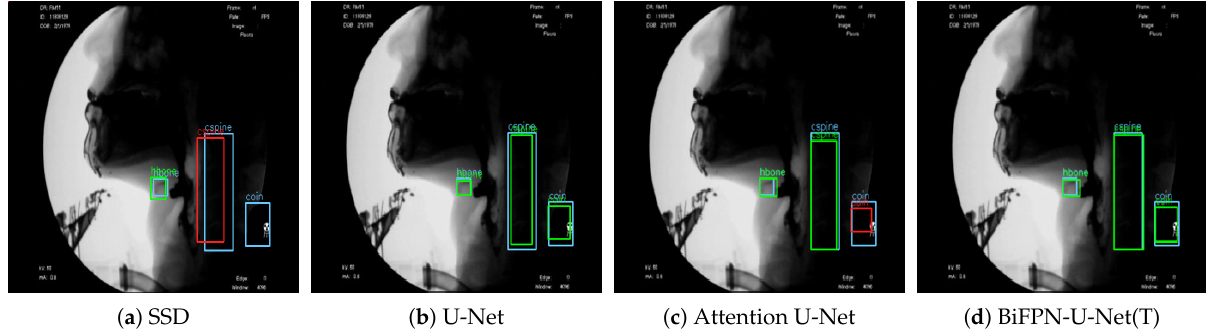
Figure 7. Detection results of each method when the coin is out of the field of view. The blue box denotes the ground truth, the green box denotes true positives, and the red box denotes false positives.